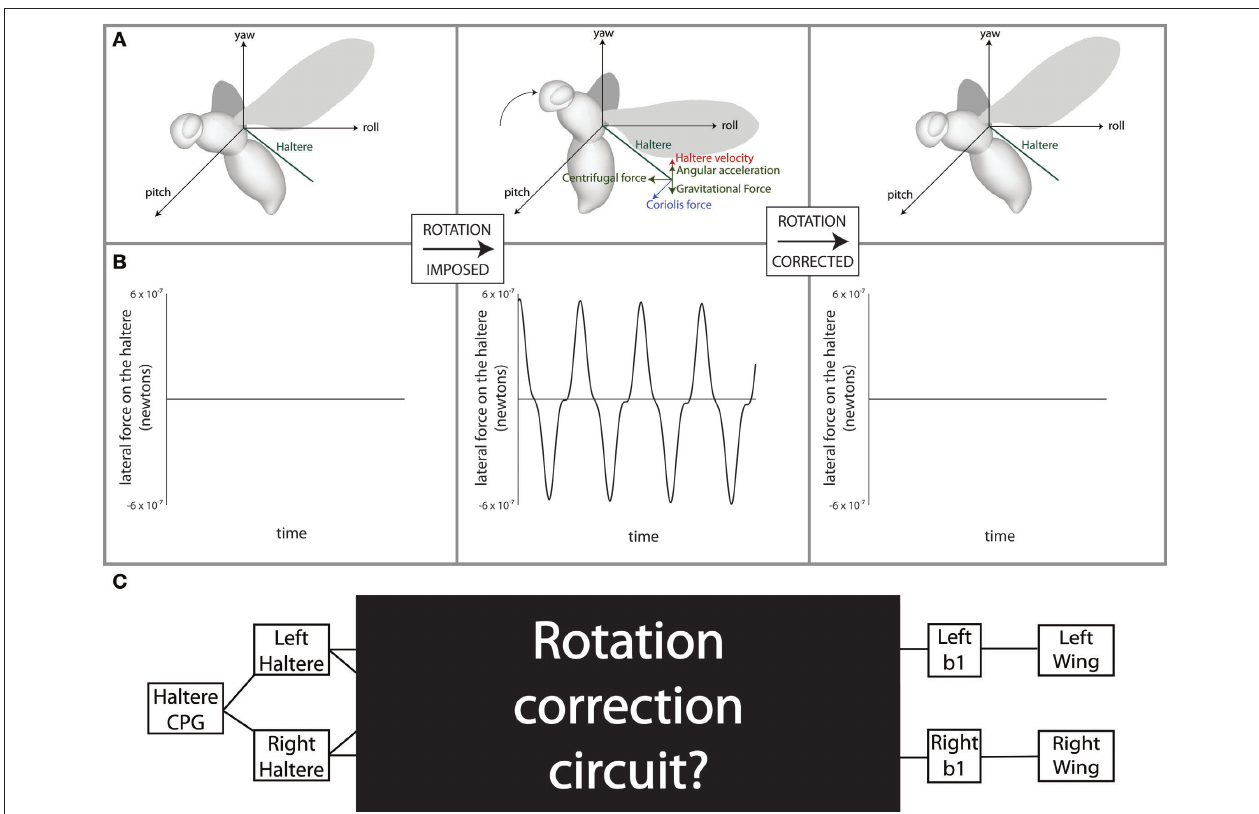
Figure 1 | Force diagram and experimental goal. (A) Force diagrams and (B) plots are shown for a situation in which the fly is rotated in the pitch direction. (C) The location of the circuit which this study seeks to uncover situated within the known anatomy of the fly’s flight system. Modified from Dickson